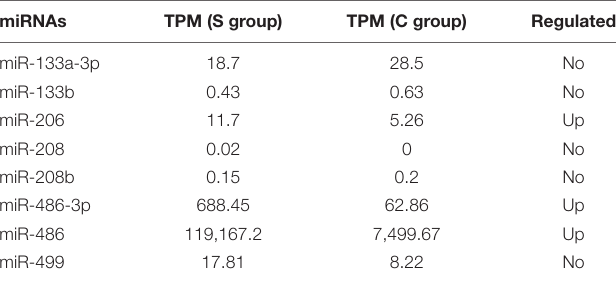
TABLE 3 | Expression level changes of myo-miRs in the athlete